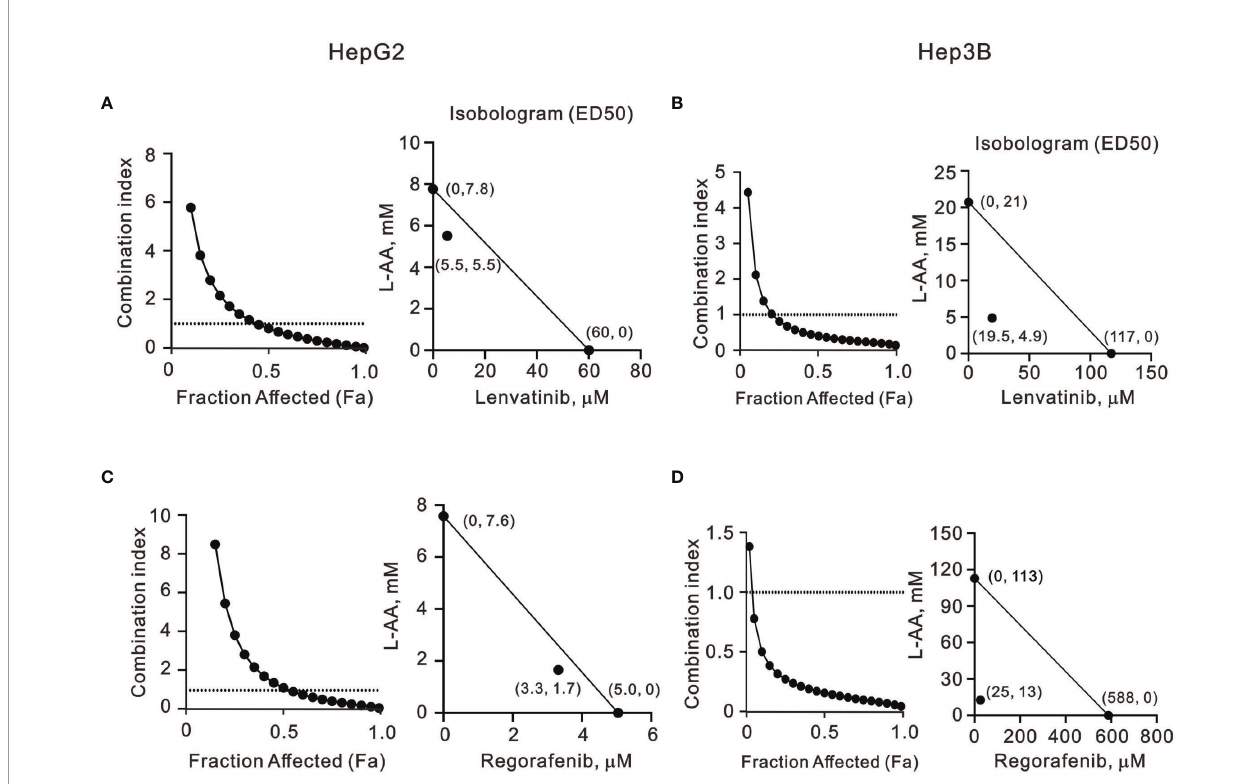
FIGURE 7 | The combination index of TKIs with L -AA in HepG2 and Hep3B cells. (A, C) HepG2 and (B, D) Hep3B cells were treated with various L -AA doses (0, 0.156, 0.3125, 0.625, 1.25, 2.5, 5, or 10 mM) combined with various lenvatinib doses (0, 0.3125, 0.625, 1.25, 2.5, 5, 10, 20, 40, or 80 m M) or regorafenib doses (0, 0.07813, 0.15625, 0.3125, 0.625, 1.25, 2.5, 5, 10, or 20 m M). Metabolic activity was measured using the MTT method. The combination index of L -AA plus lenvatinib or regorafenib in (A, C) HepG2 and (B, D) Hep3B cells. Isobolograms (ED 50 ) of lenvatinib or regorafenib were calculated using CalcuSyn